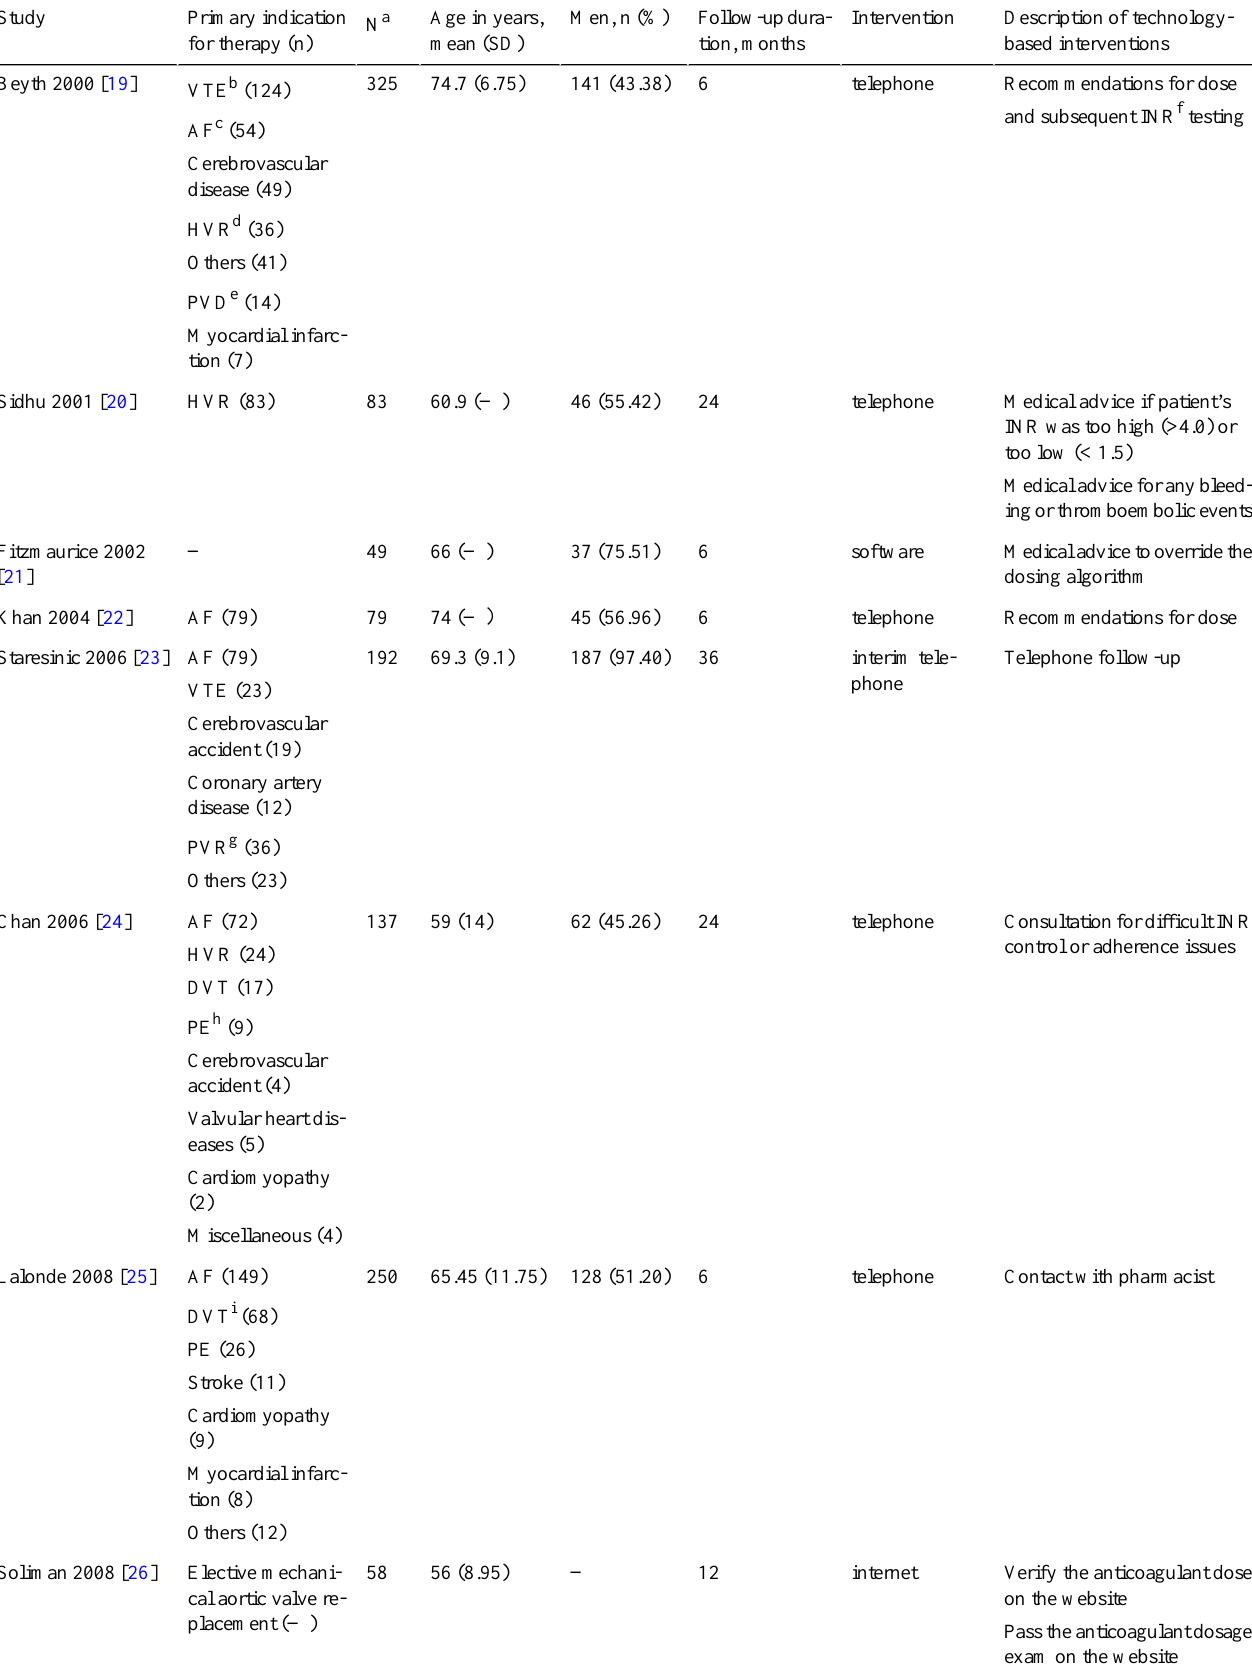
Table 1. Baseline characteristics of the included studies.